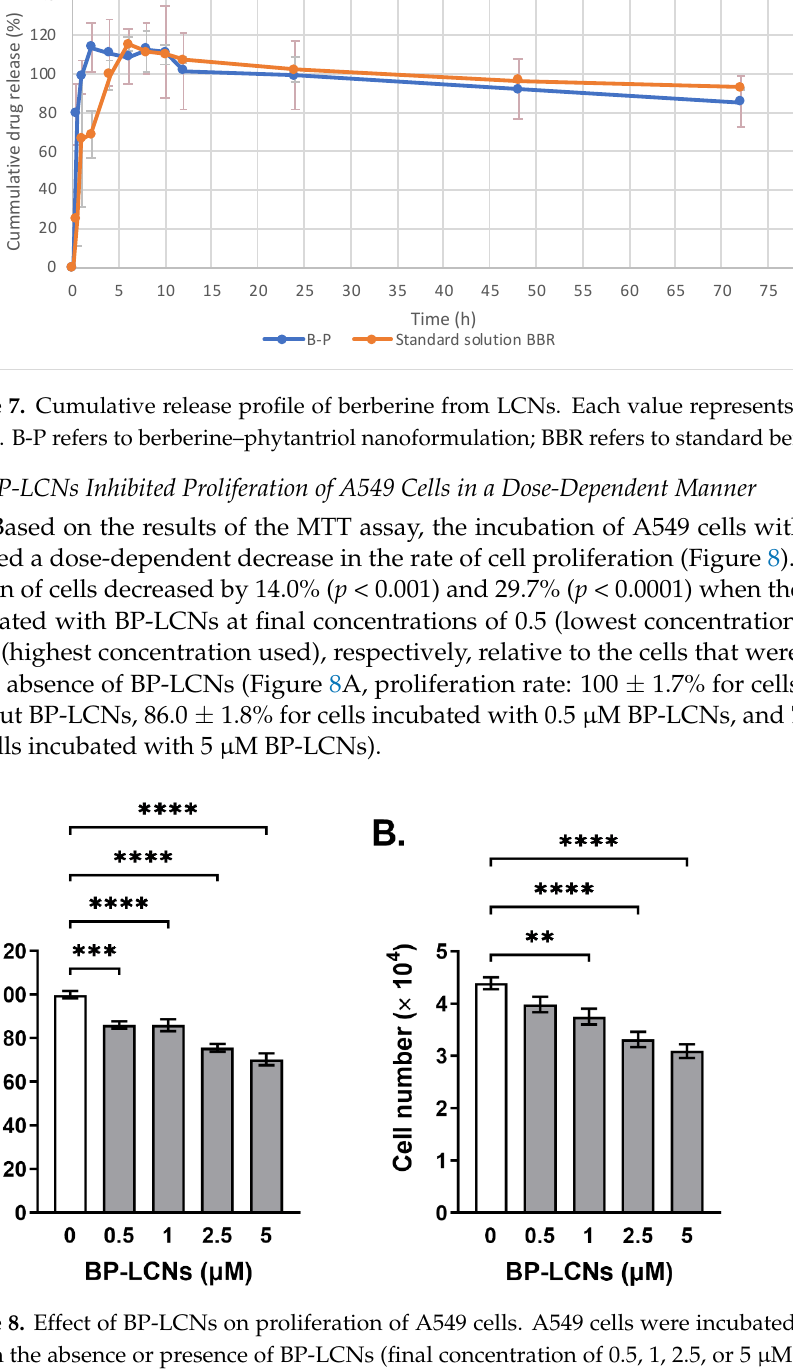
Table 4. Characterization parameters of BP-LCNs.